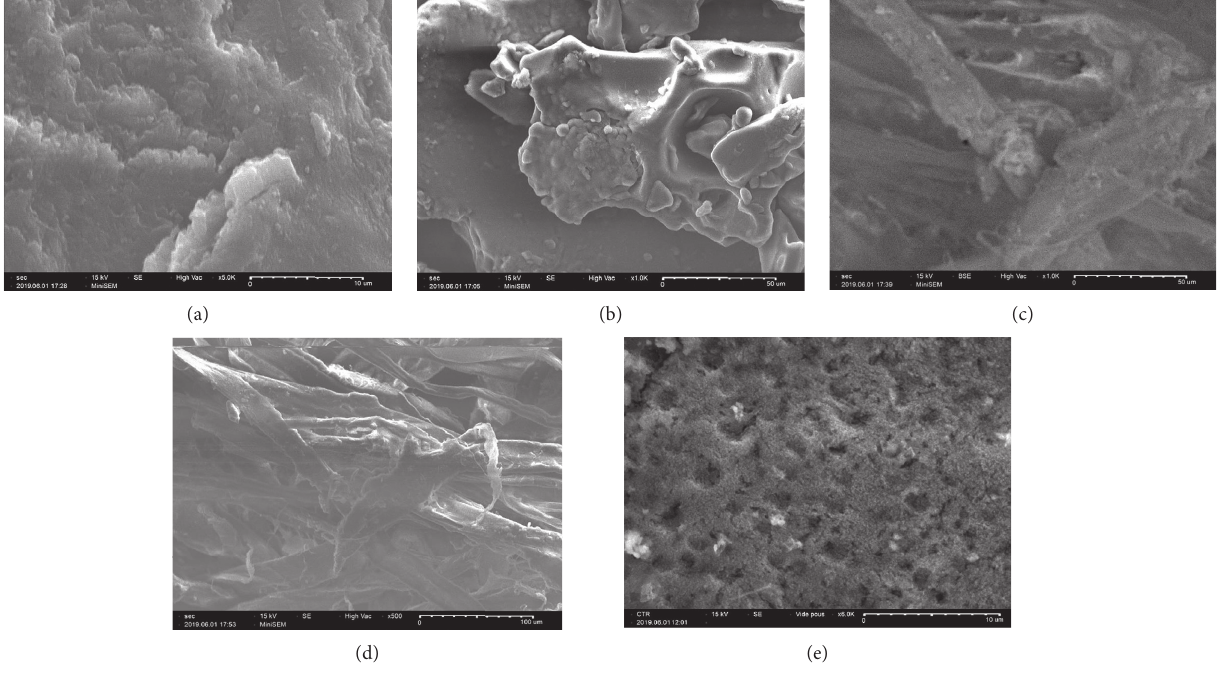
Figure 7: SEM images of TG (a, b) and CMTG-GA (c, e).